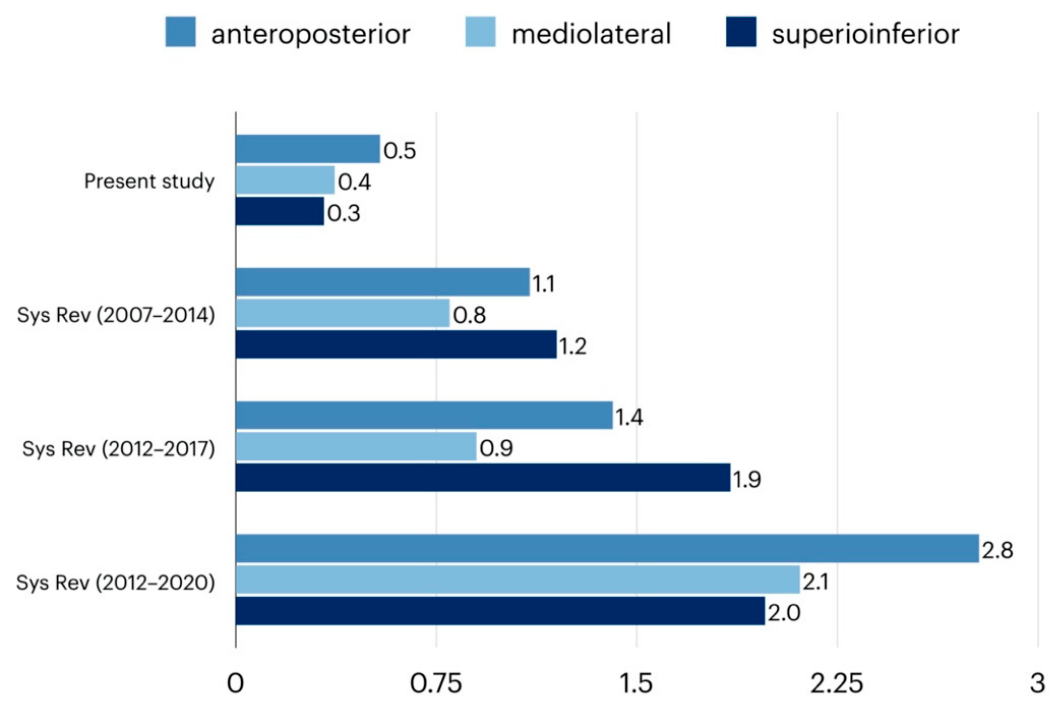
Figure 5. Overview of translational errors concerning studies on virtual planning in orthognathic surgery. Measurements of the present study compared to the results of three systematic reviews (Sys Rev) covering the years 2007–2020 [4,26,35].